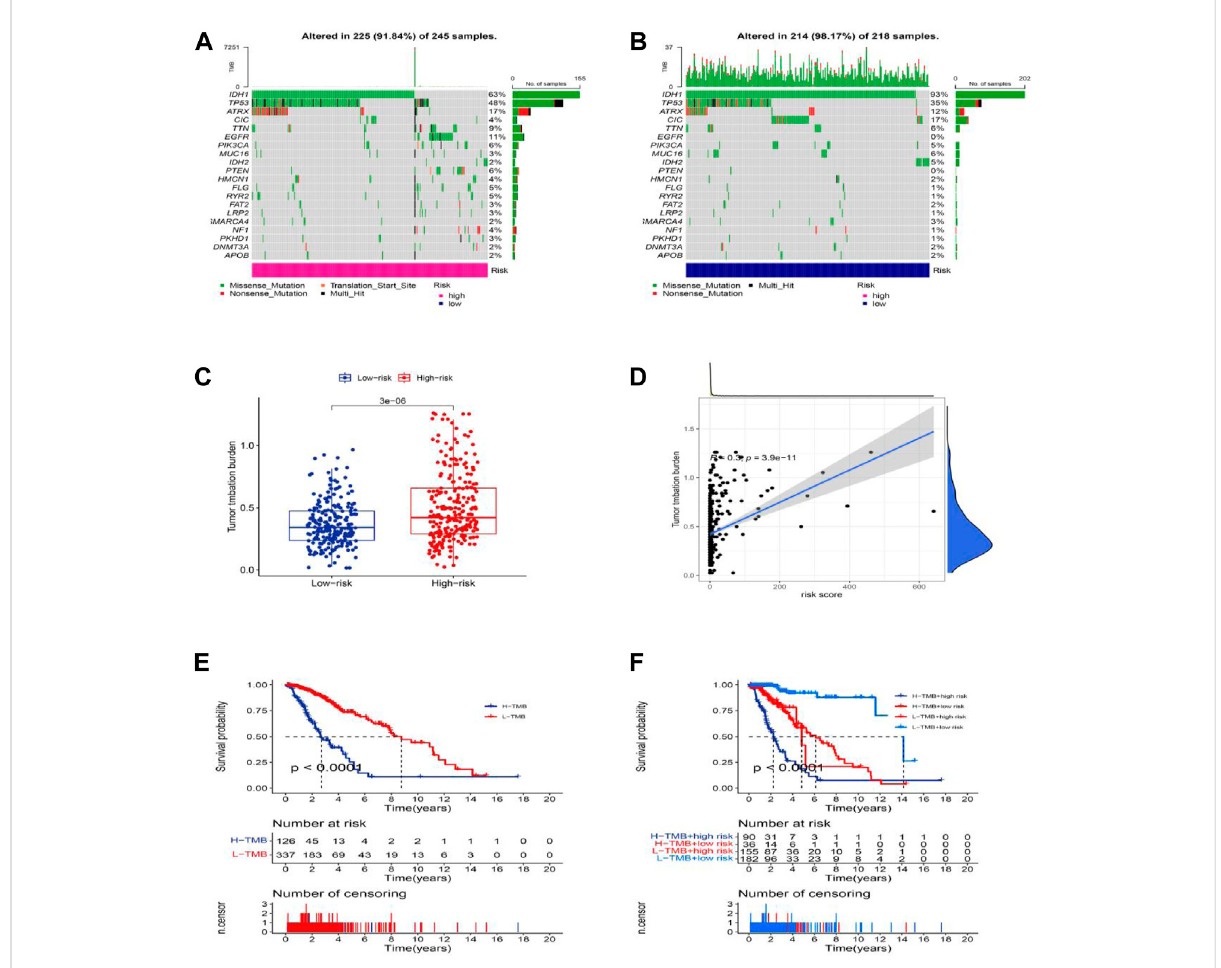
FIGURE 9 Somatic mutation landscapes in AML. (A,B) The top 20 mutation driving genes with the highest change frequency in the high-risk and low-risk groups. (C) Differences in TMB between high and low-risk groups. (D) Correlation between TMB and risk score. (E) Kaplan-Meier survival curves